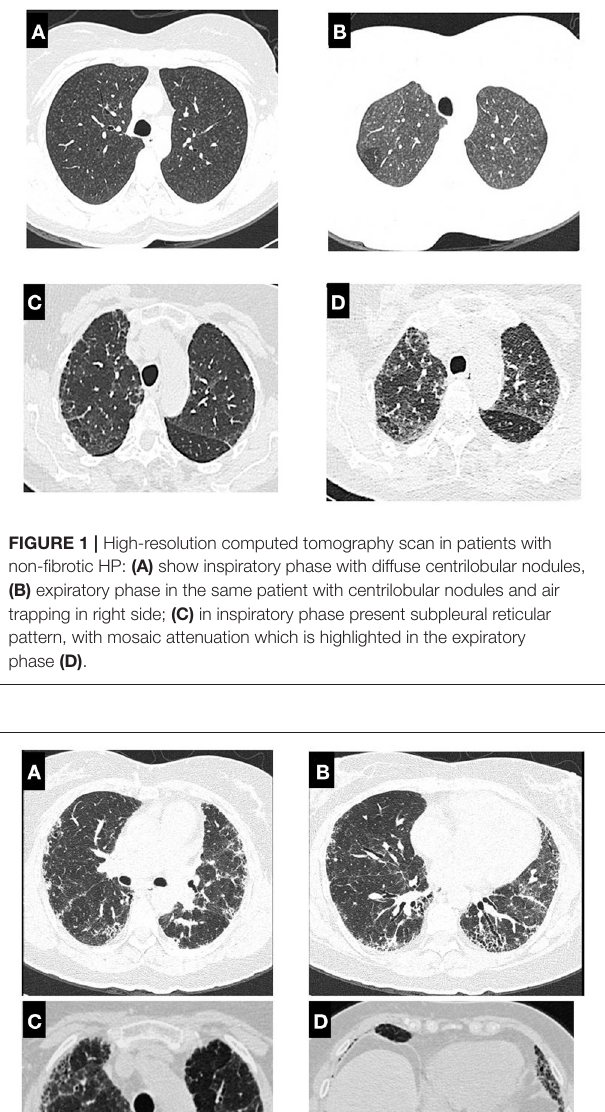
FIGURE 4 | Lung biopsy sample from a patient with non-fibrotic hypersensitivity pneumonitis showing cellular chronic interstitial pneumonia and a poorly formed non-necrotizing granuloma. Hematoxylin and eosin staining, magnification: 40 ×